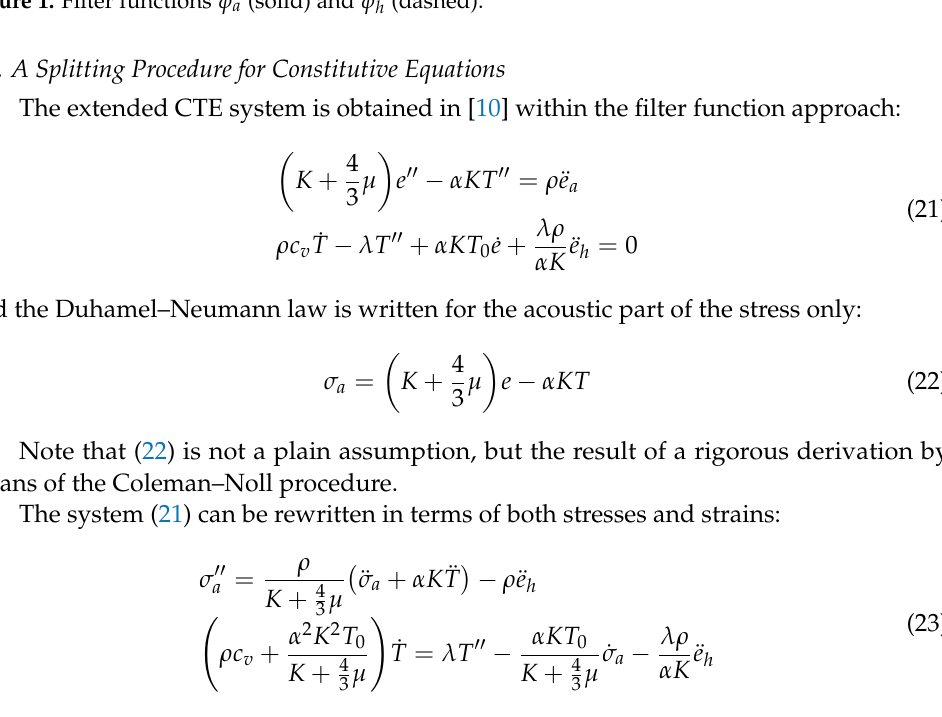
Figure 1. Filter functions ˆ ϕ a (solid) and ˆ ϕ h